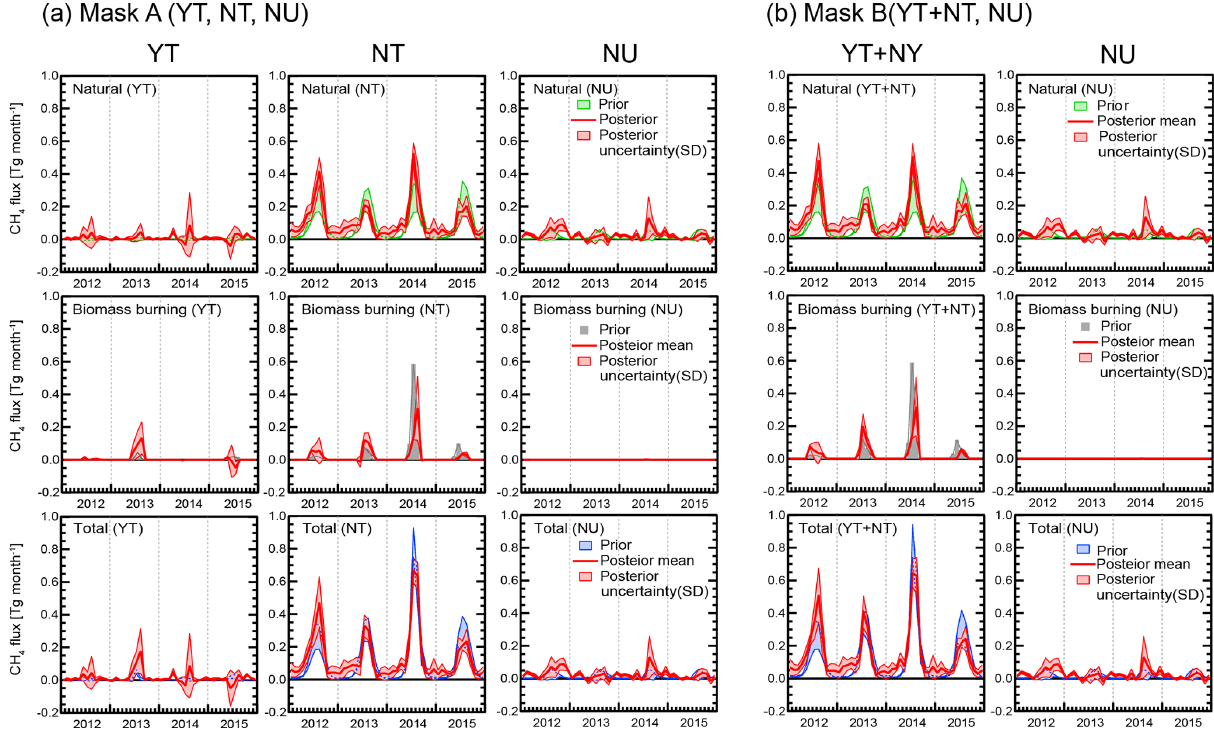
Figure 8. Monthly posterior mean fluxes with (a) subregion mask A (YT, NT, NU) and (b) mask B (YT + NT, NU). Posterior mean flux is an average of nine experiments with three models (FLEXPART_EI, FLEXPART_JRA55, and WRF-STILT) and three prior emission cases (VIS, GEL, and WetC). The posterior SD is shown by the red shaded area. Prior fluxes for natural emissions include wetland flux, soil uptake, and anthropogenic emissions. Biomass burning prior fluxes are from GFAS. The (non-red) shaded areas for natural and total prior fluxes indicate the range of prior